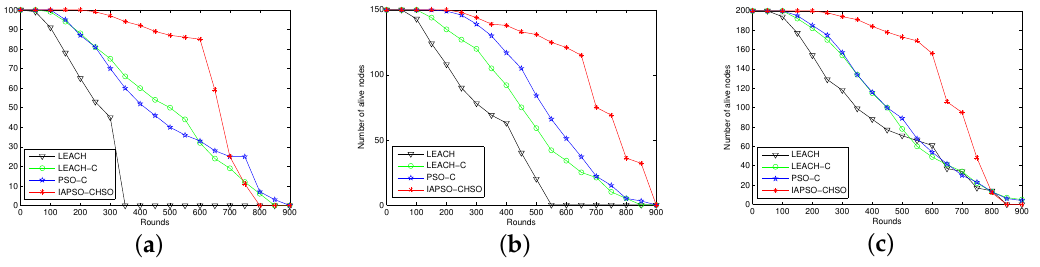
Figure 6. Comparison in terms of number of alive nodes with 100 to 200 nodes. ( a ) 100 nodes with 6 cluster heads; ( b ) 150 nodes with 9 cluster heads; ( c ) 200 nodes with 12 cluster